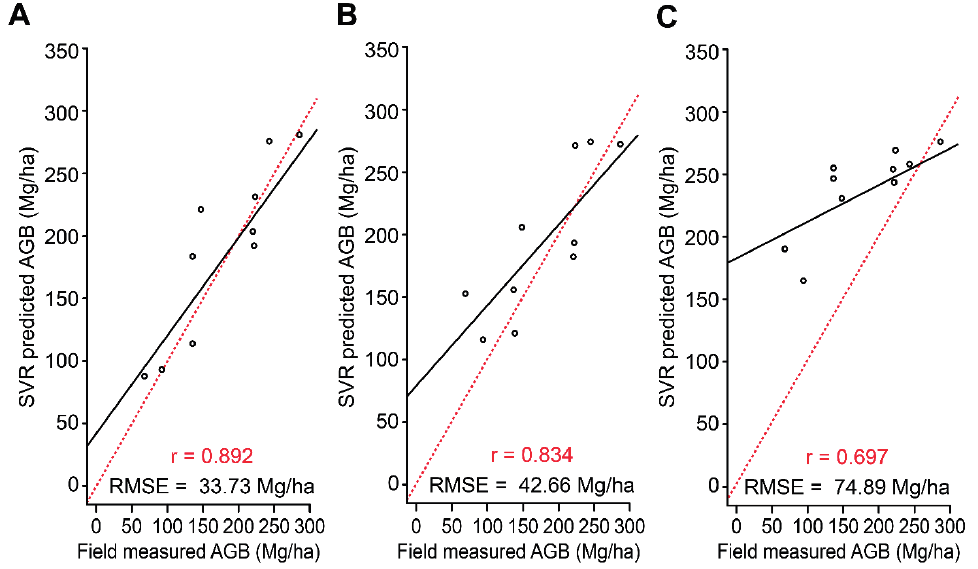
Figure 5. SVR-predicted AGB vs. field-measured AGB, as derived from Google Earth™ imagery via the GLCM method using ( A ) HCV + VCH, ( B ) HCV only and ( C ) texture variables (TV) only. Solid black lines represent regression lines; red dashed lines represent 1:1 correspondence